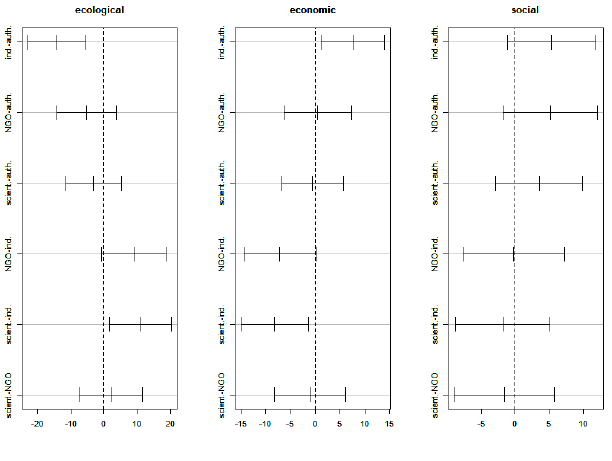
Fig. 5 . Ninety-five percent stakeholder group-wise confidence level for difference in mean level of pillar score (Tukey’s HSD). The y-axis shows the pairwise combinations of stakeholder